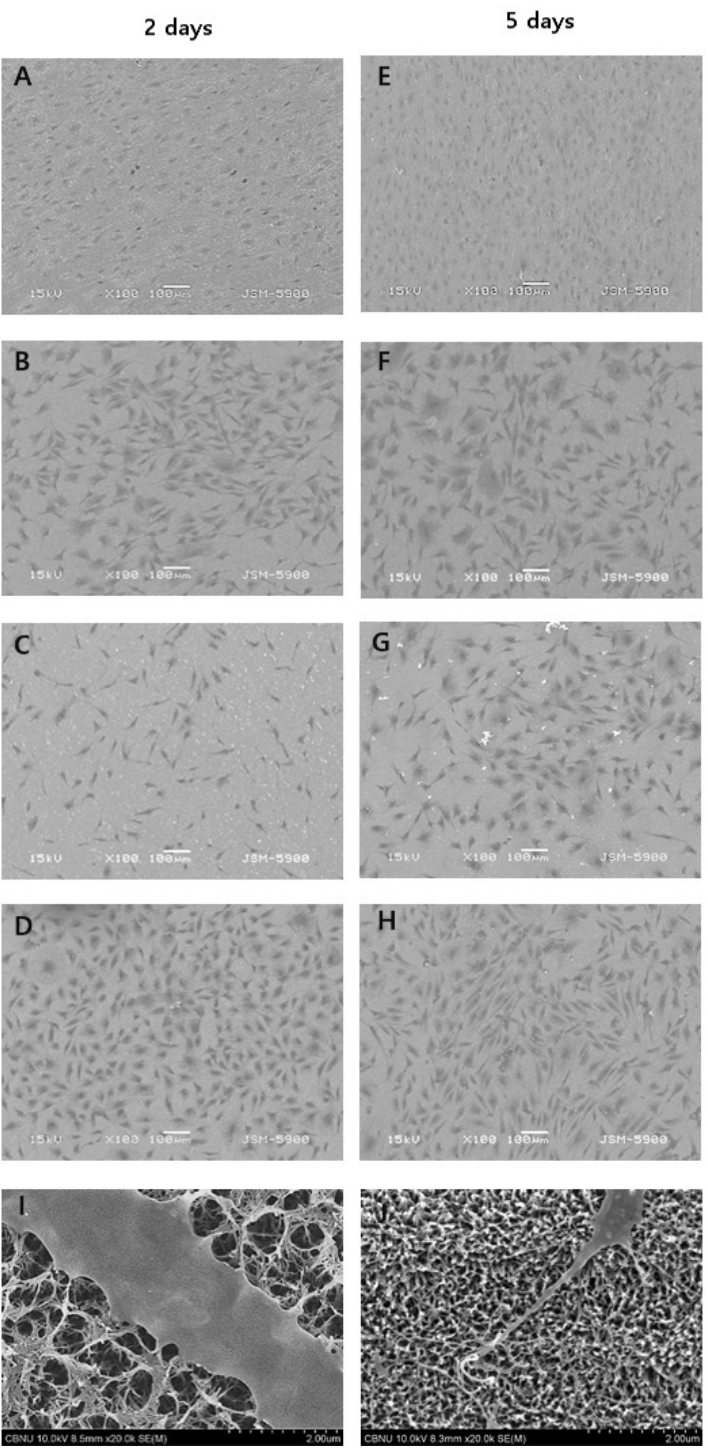
Figure 7. SEM images of cell morphologies: ( A , E ) PT, ( B , F ) PTN, ( C , G ) PTNA, and ( D , H ) PTNAC after the ( A – D ) 2 and ( E – H ) 5 days MC3T3-E1 cell cultures and ( I ) PTNA, and ( J ) PTNAC with a high magnification.